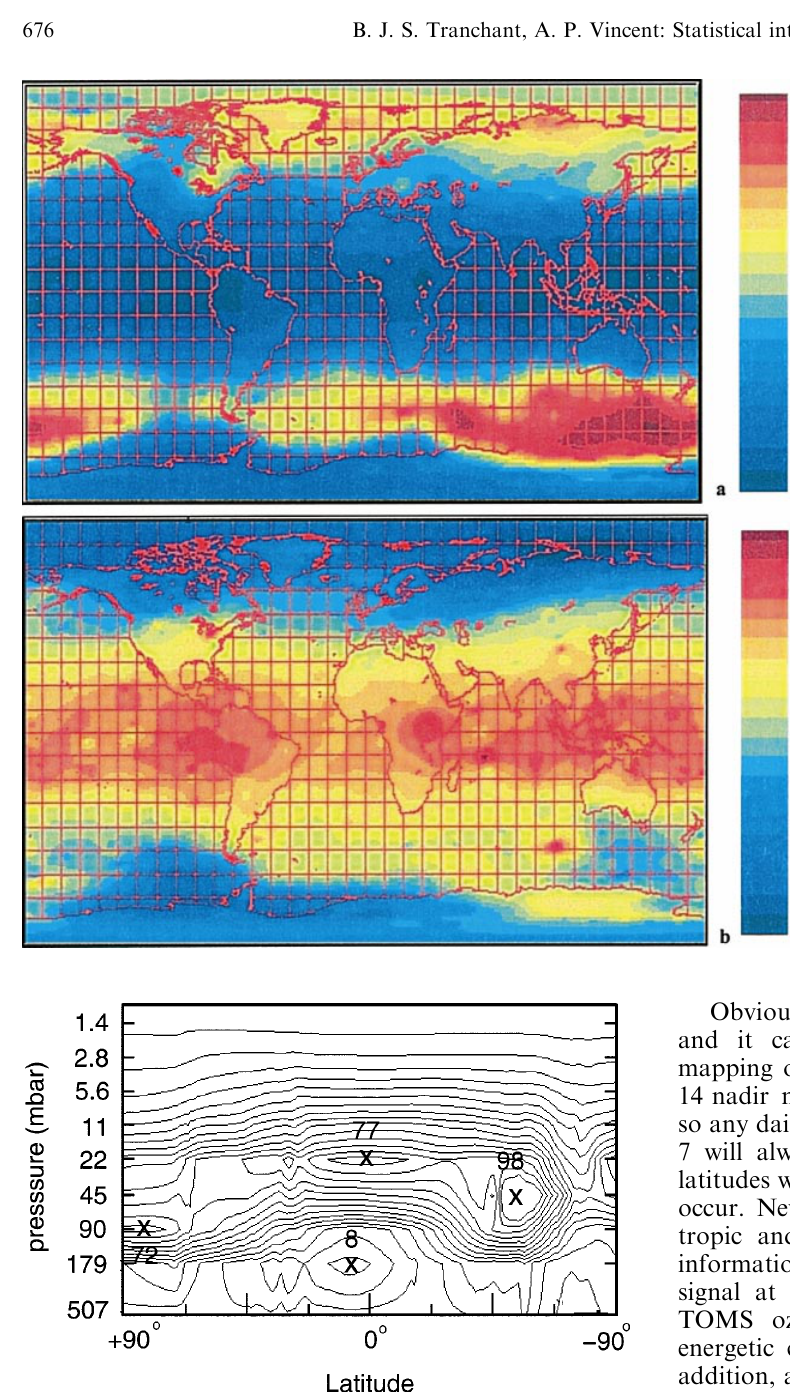
Fig. 9. Latitude-altitude cross section of the total amount of ozone in Dobson Units at 0 (cid:14) longitude on October 5, 1988, obtained using ordinary kriging. Contour interval is